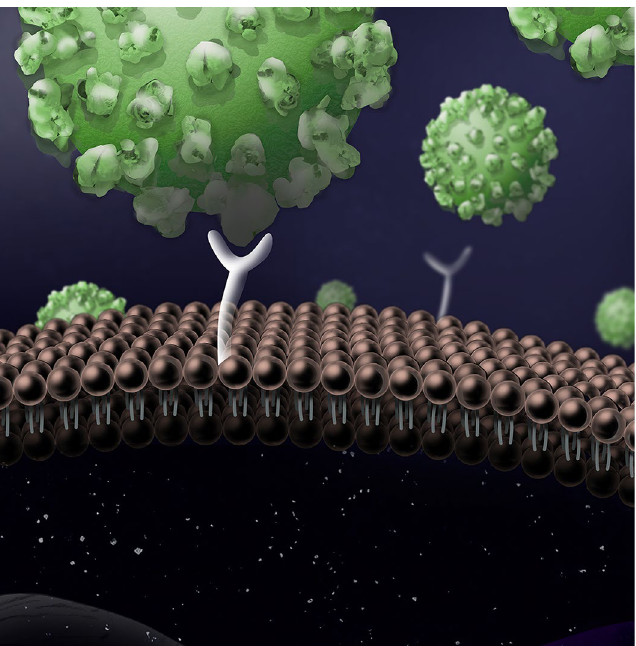
Figure 1. The SARS-CoV-2 spike protein facilitates host cell invasion by binding with cell membrane embedded ACE2